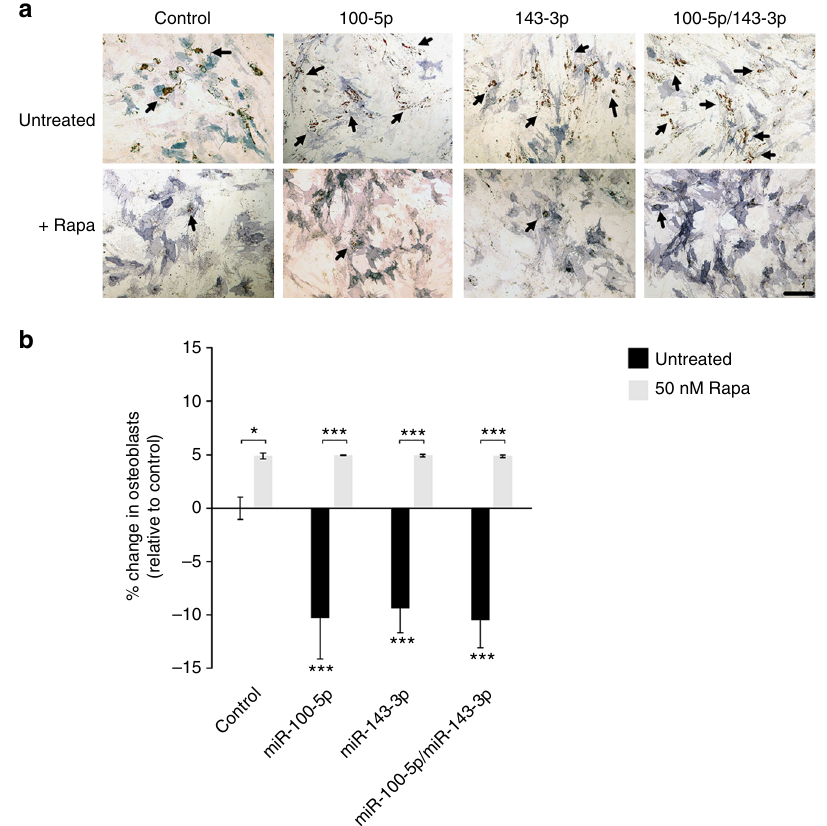
Fig. 5 Rapamycin over-rides the effect of miRNA inhibitors. a Representative images of alkaline phosphatase (blue) and Oil Red O (red) staining of hMSCs transfected with miRNA inhibitors with and without 50 nM rapamycin. Scale bar, 100 μ m. b Differentiation bias of hMSCs treated with miRNA inhibitors with (grey bars) and without (black bars) 50 nM rapamycin. Data is shown as mean ± SD of the change in proportion of osteoblasts (see Supplementary Fig. 7 for additional donors). Samples were analysed by one-way ANOVA with Tukey post hoc testing. Statistically different samples are denoted by * p < 0.05, ** p < 0.01 and *** p <